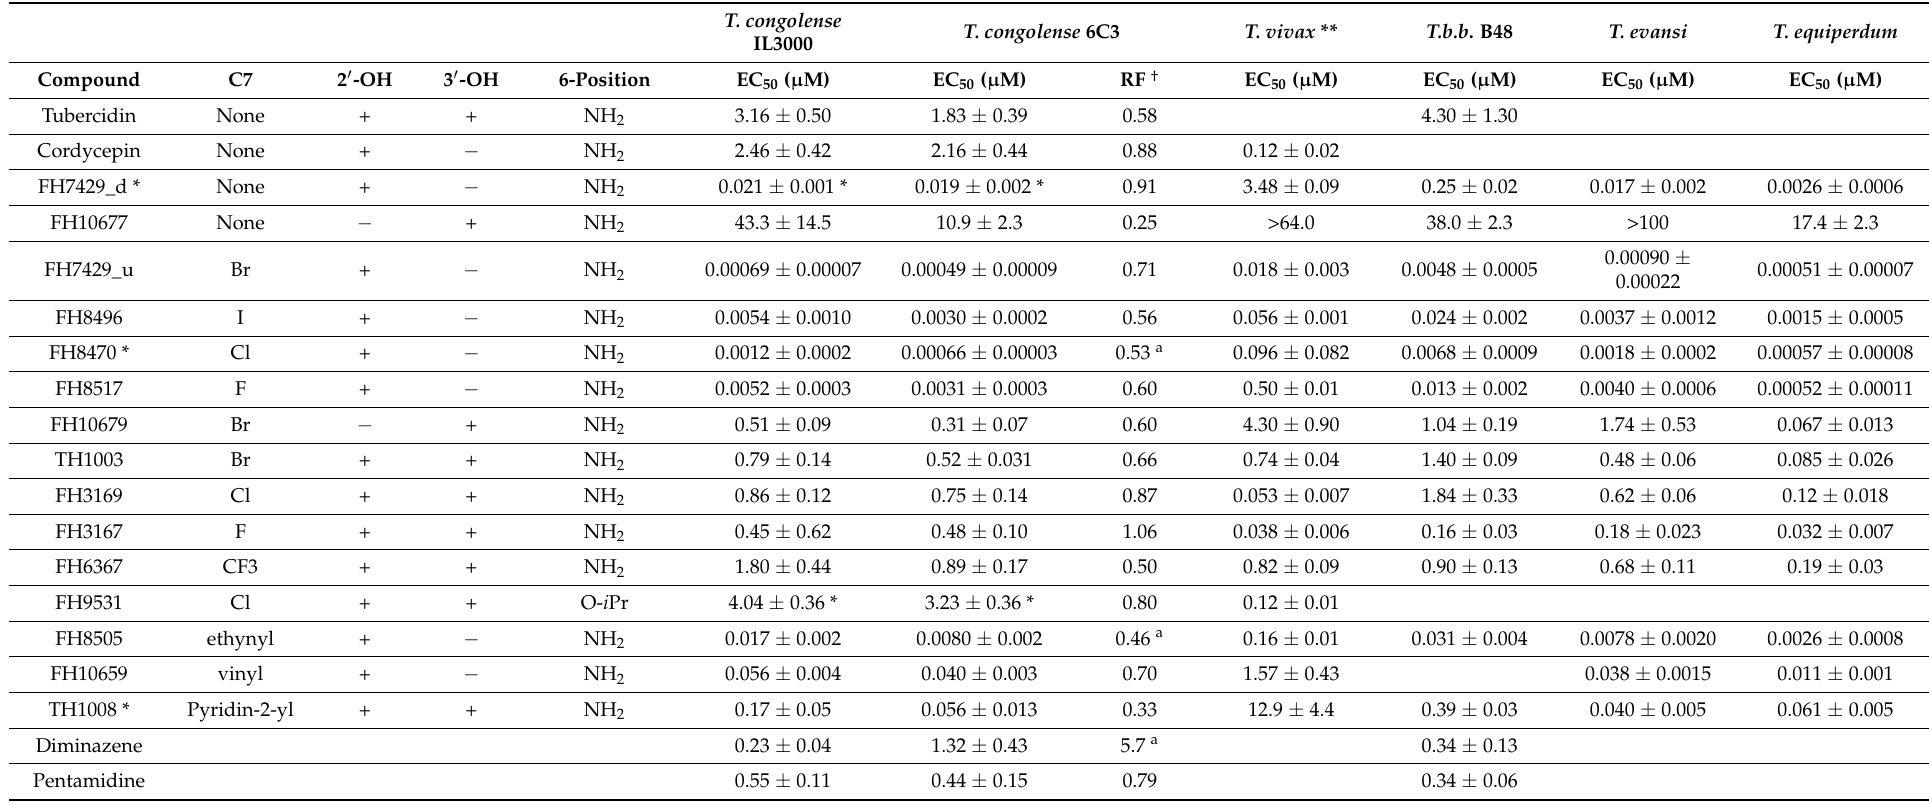
Table 8. Effect of tubercidin analogs with substitutions on C7 on Trypanosoma species and strains in